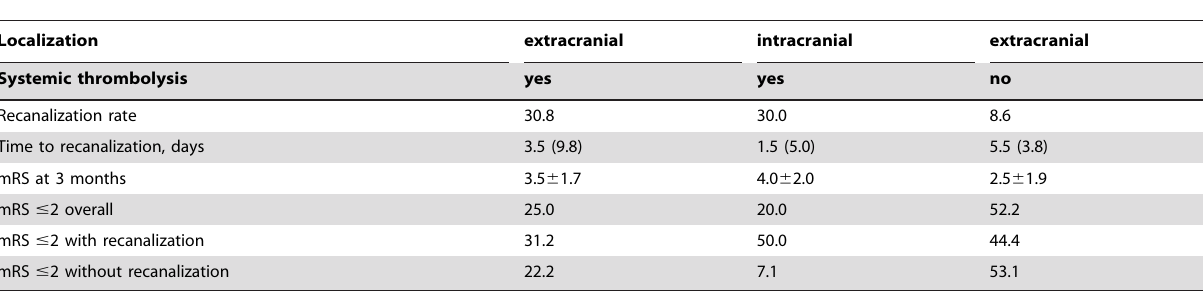
Table 2. Outcome parameters of the three